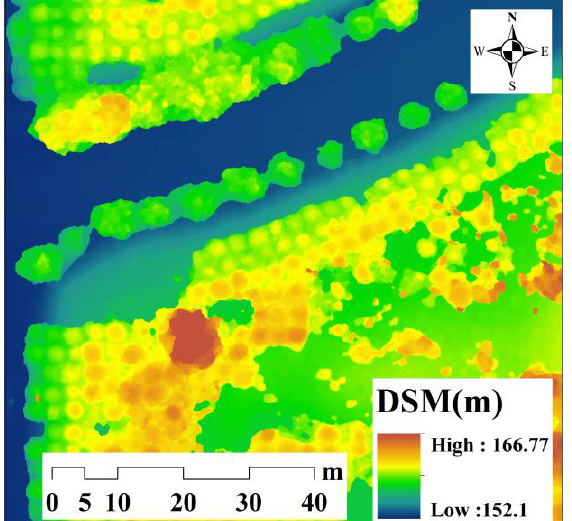
Figure 2 . Digital surface